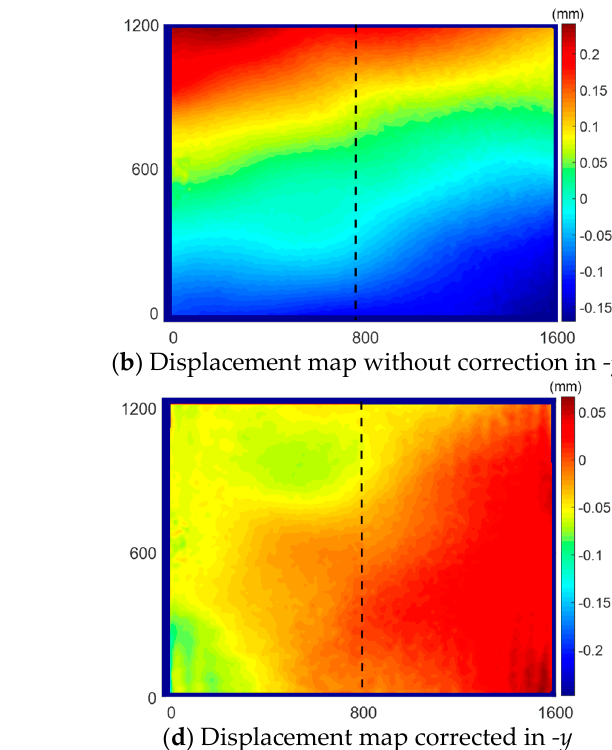
Figure 3. ODS test setup.